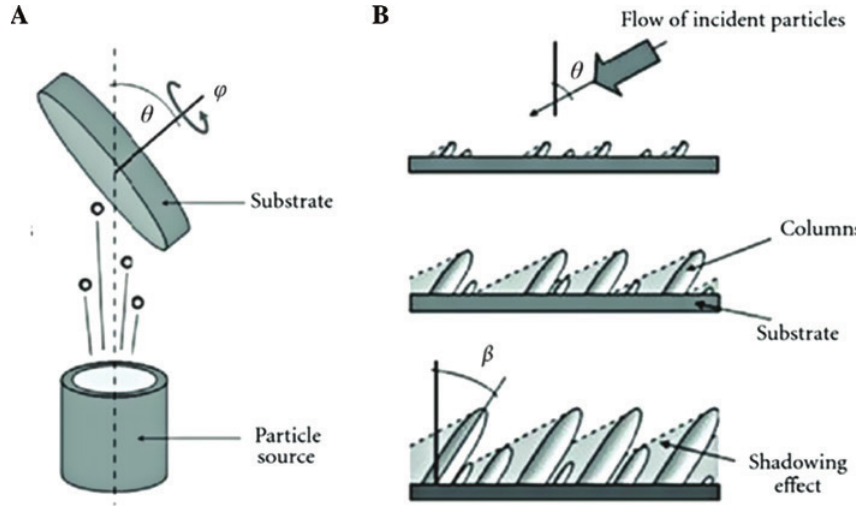
Figure 2: Principles of GLAD [28]. (A) The deposition configuration of GLAD. (B) The geometric shadowing effect and surface diffusion of the adatoms of GLAD for forming